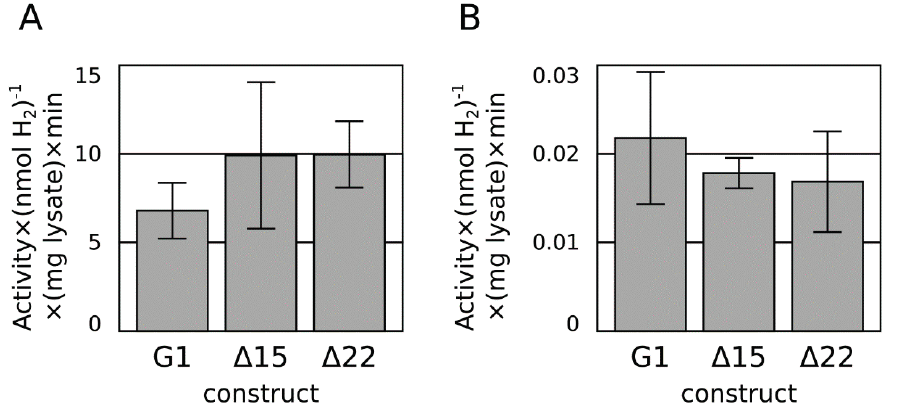
Figure 3. Methyl viologen-mediated ( A ) and methyl viologen-free (dithionite only) ( B ) in vitro hydrogen production assay from extracts of E. coli over-expressing the G1 hydrogenase and Δ 15 and Δ 22 truncations of the C -terminal